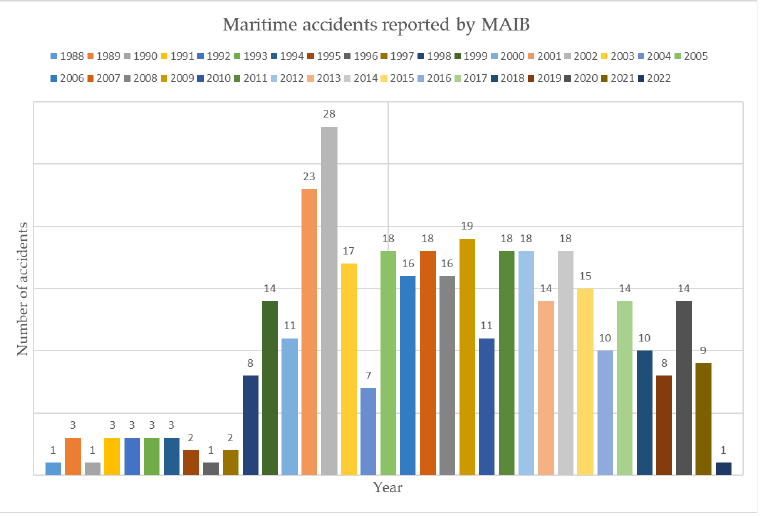
Figure 1. Maritime accidents reported by MAIB.